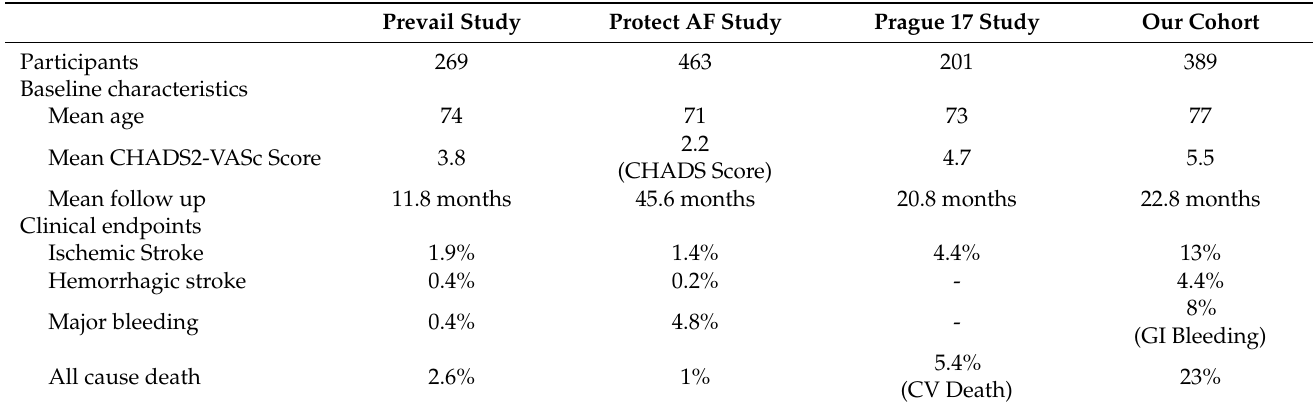
Table 2. A comparison of baseline characteristics and clinical outcomes of the current study and the relevant randomized controlled